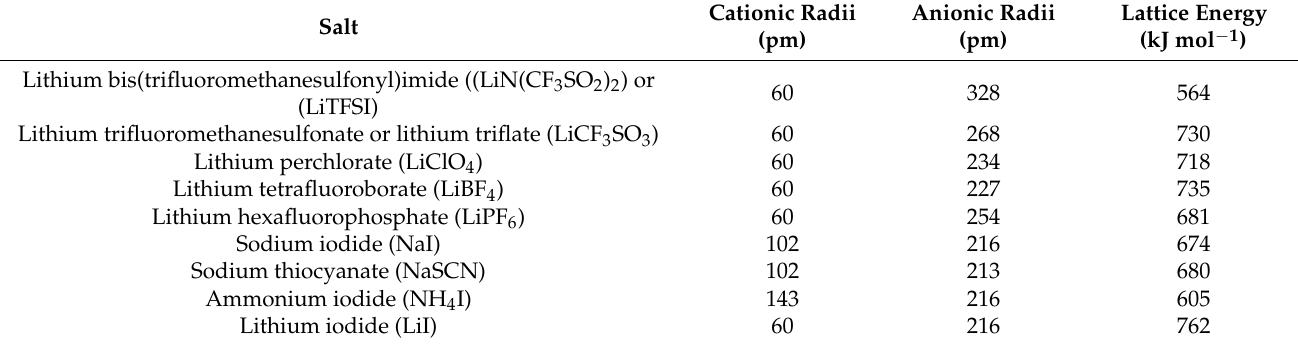
Table 2. Some popular salts used in polymer electrolytes, along with their properties [18,26,27].